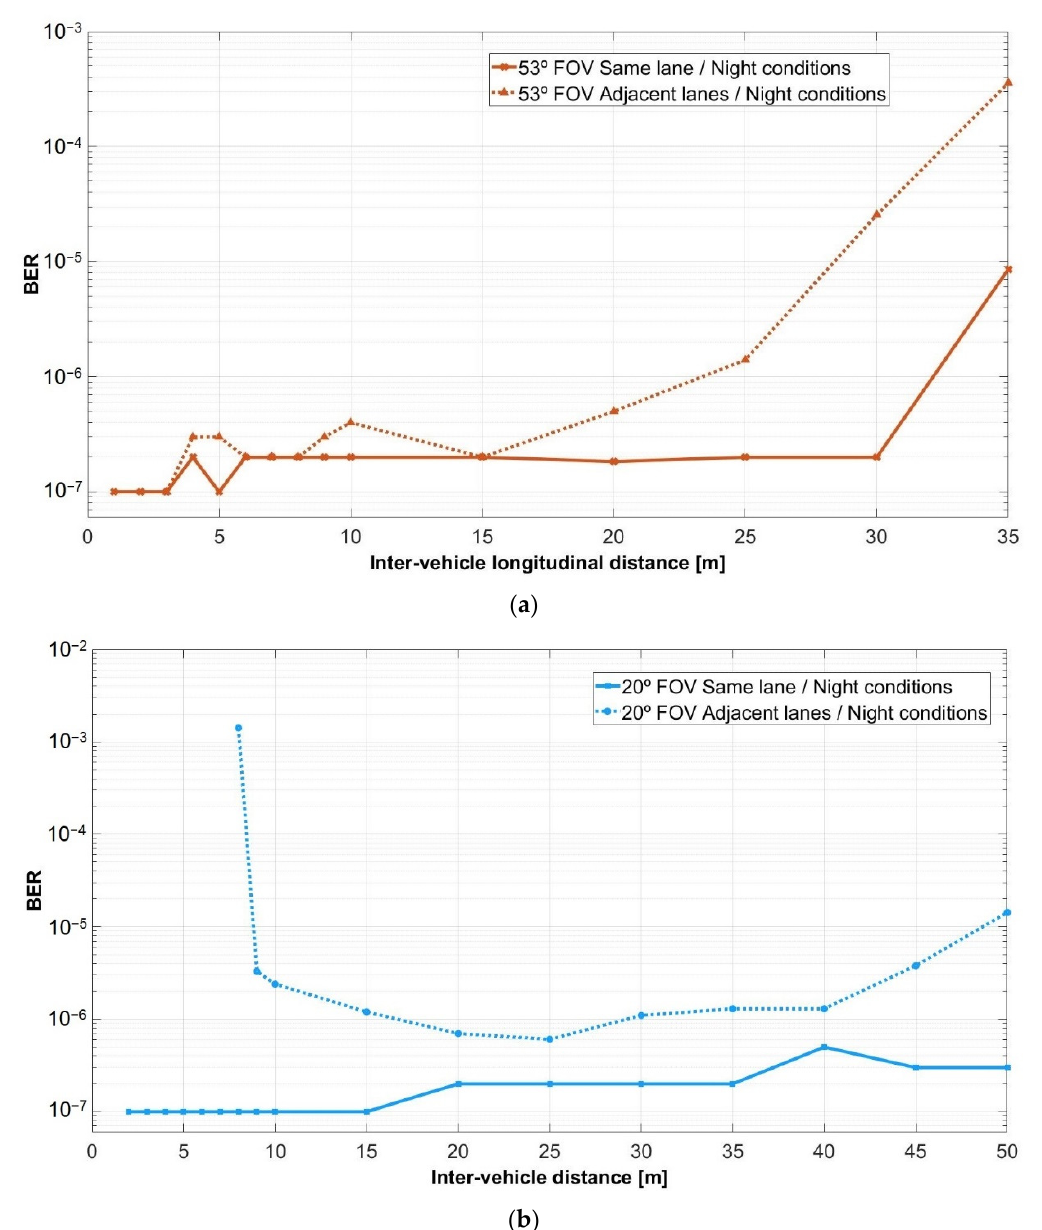
Figure 11. Summary of the V2V experimental BER results for the tests performed in night conditions under the influence of fluorescent lights: ( a ) for a ±53° reception angle; and ( b ) for a ±20° reception angle.